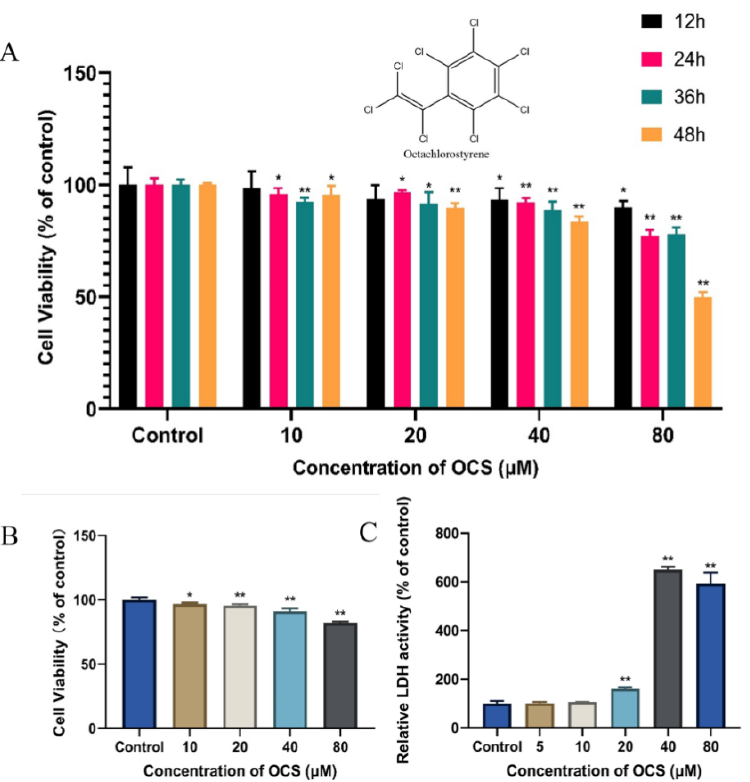
Figure 1. The cell viability of HepG2 cells after treatment with OCS for 12–48 h based upon the MTT assay ( A ) and the CCK8 assay ( B ). The LDH release ( C ) of HepG2 cells was performed after treatment with OCS for 24 h. Each value represents the mean ± S.D. of three independent experiments ( n = 3). * ( p < 0.05) or ** ( p < 0.001) denote a significant difference relative to the control group.